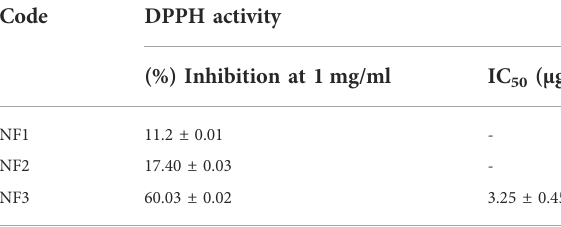
TABLE 2 The antioxidant activities of prepared nano fi